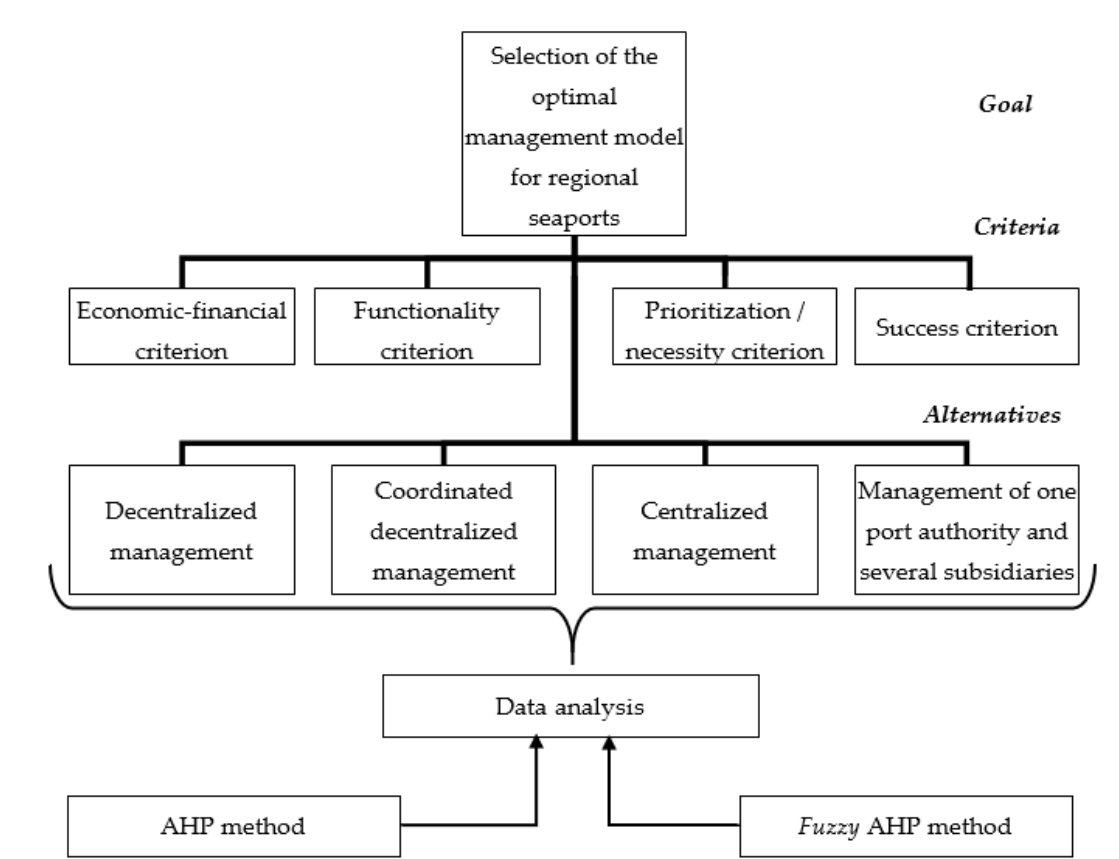
Figure 1. Hierarchy structure elements—research flowchart.